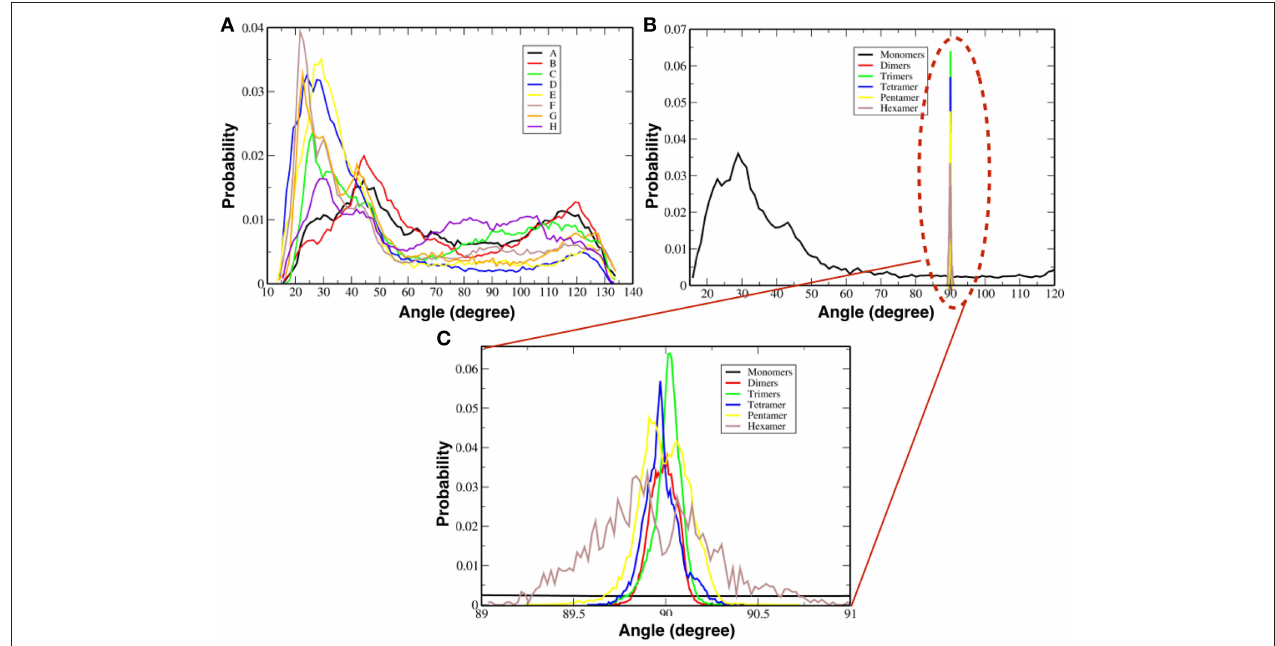
FIGURE 7 | Probability distributions of the orientation of monomers and oligomers. (A) Probability distributions for each single TFP monomer. (B) Probability distributions for the oligomeric state. (C) Close-up view of the probability distributions as calculated for oligomeric states observed in our simulations.